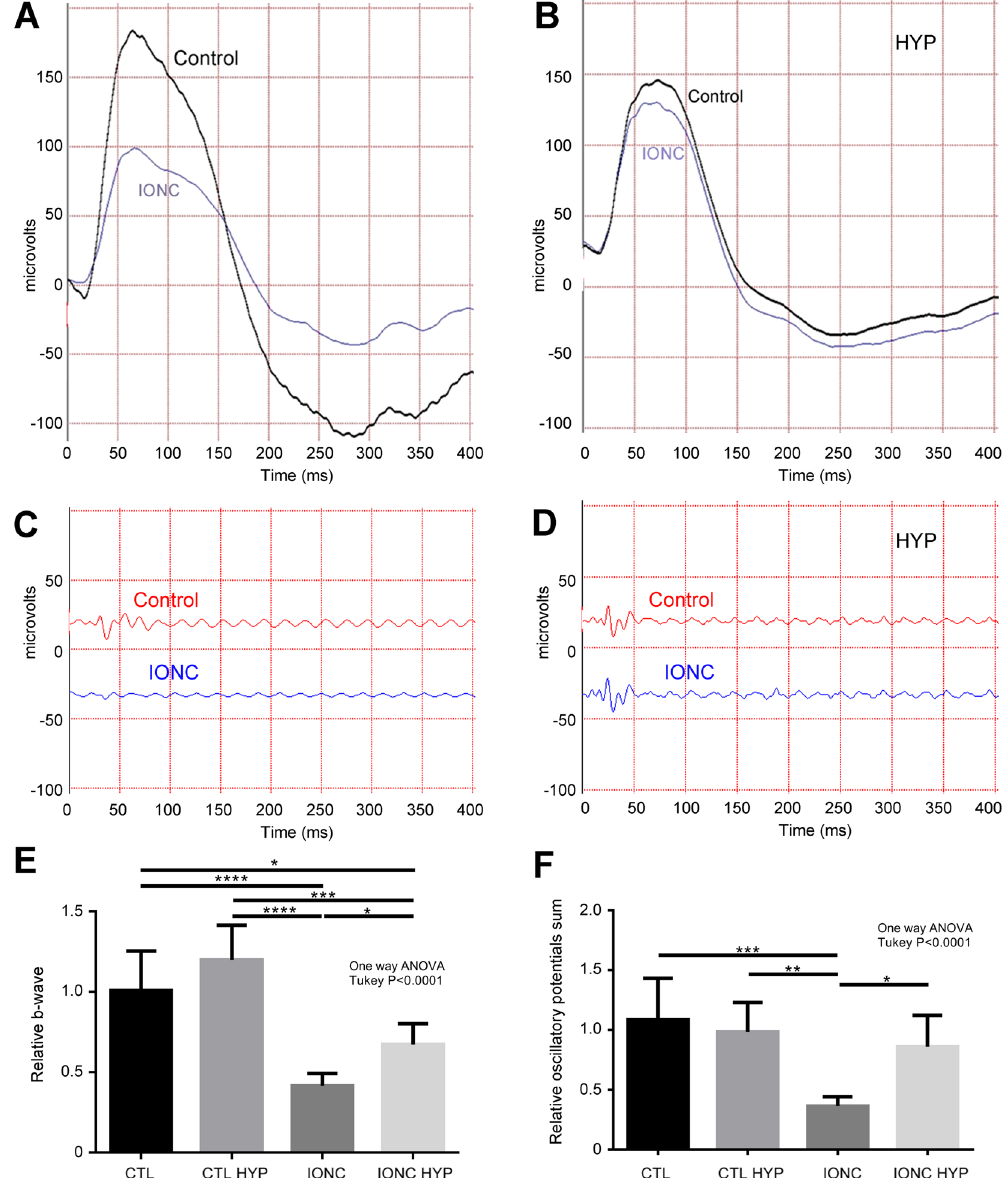
temperature ( A , C ) or subjected to therapeutic hypothermia ( B , D ). Quantification of the relative (left eye/right eye) b-waves ( E ) and oscillatory potentials ( F ) are represented as histograms for the 4 experimental groups: sham-operated rats (CTL), sham rats treated with hypothermia (CTL HYP), rats subjected to IONC (IONC), and animals subjected to IONC and treated with hypothermia (IONC HYP). Bars represent the mean ± SD of all samples (n = 10 animals per group). Asterisks represent statistically significant differences. * p < 0.05; ** p < 0.01; *** p < 0.001; **** p <